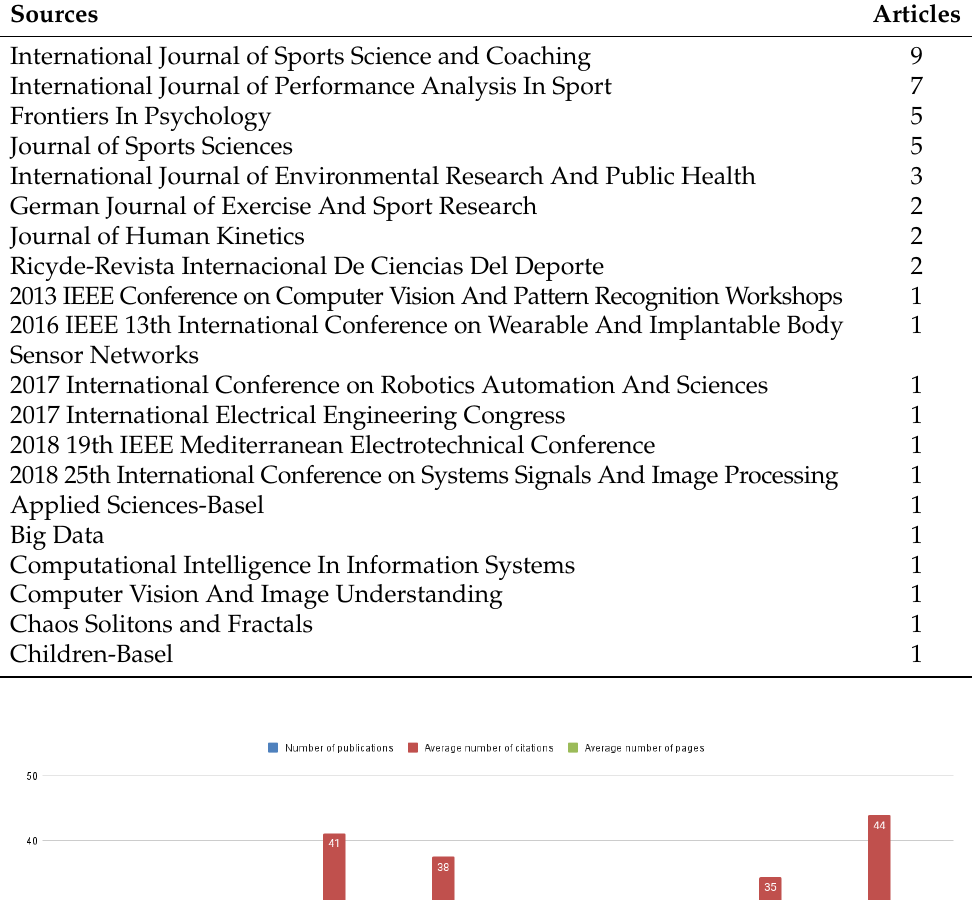
Table 4. The 20 most relevant sources.